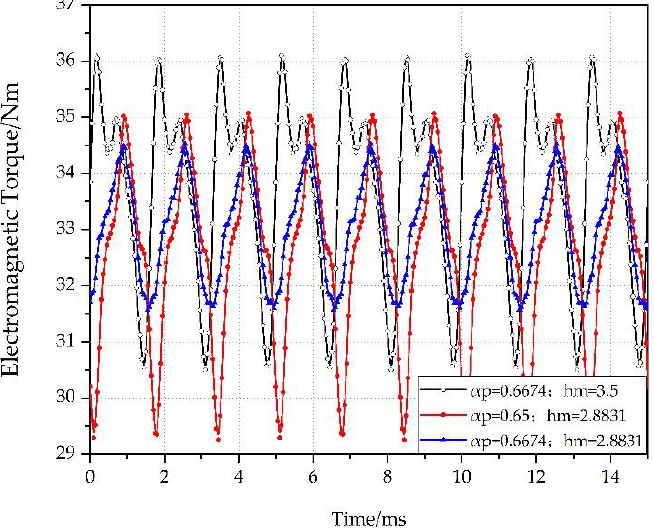
Figure 20. Comparison of electromagnetic torque.